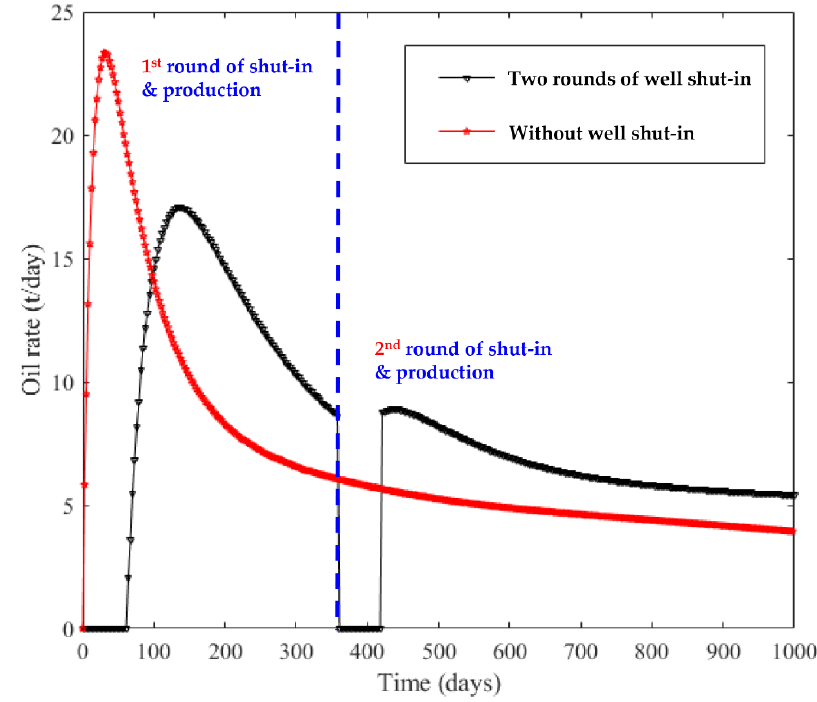
Figure 13. Daily oil rate with two rounds of well shut ‐ in operations.